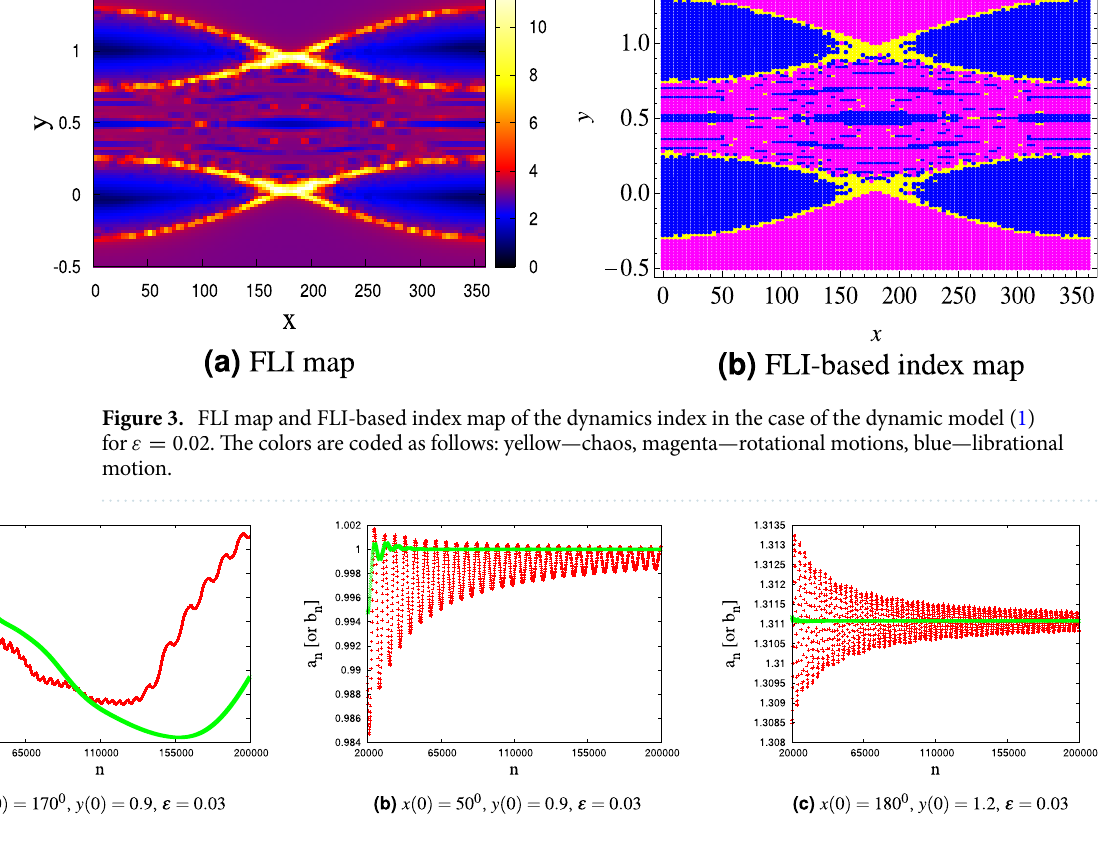
Figure 4. The terms of the series a n (red) and b n (green), 2 × 10 4 ≤ n ≤ 2 × 10 5 , for chaotic ( a ), librational ( b ), and rotational ( c ) motions, for the Hamiltonian